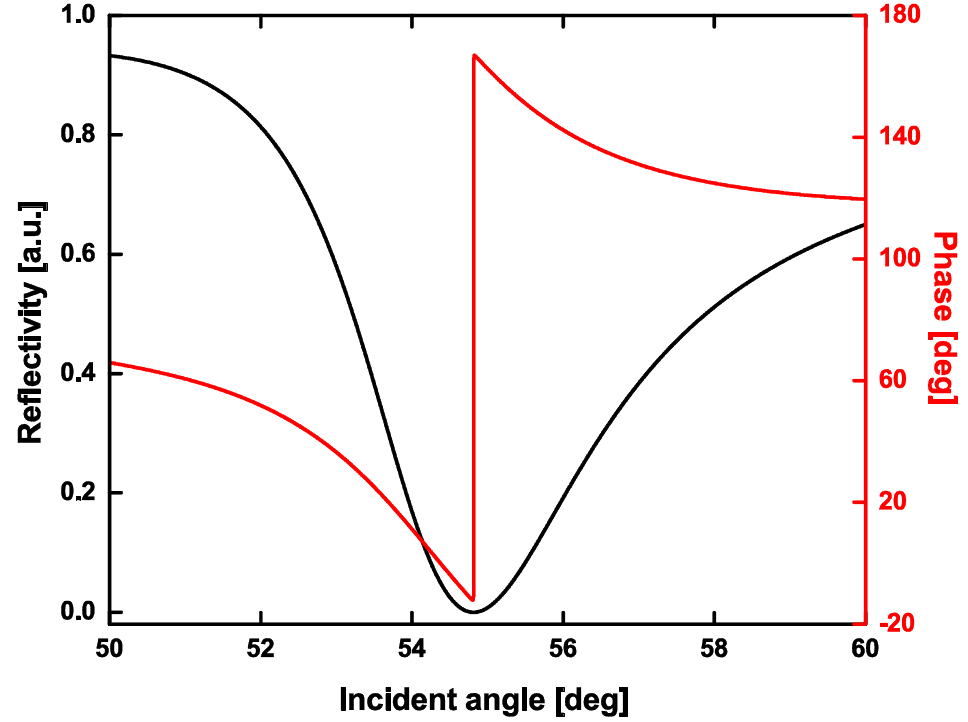
Figure2. The reflectivity (black) andphase (red)variation with respect to the incidentangle. The number of BlueP and graphene layers is 2 and 4, respectively. The Au film thickness is 42 nm. The incident wavelength is 632.8